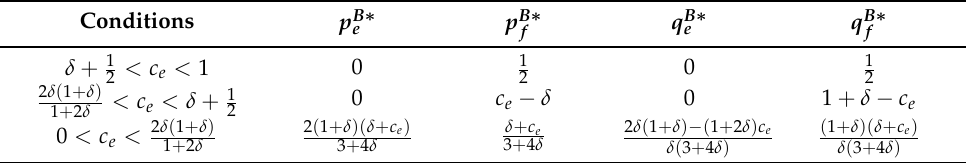
Table 4. Equilibrium price and quantity under the basic